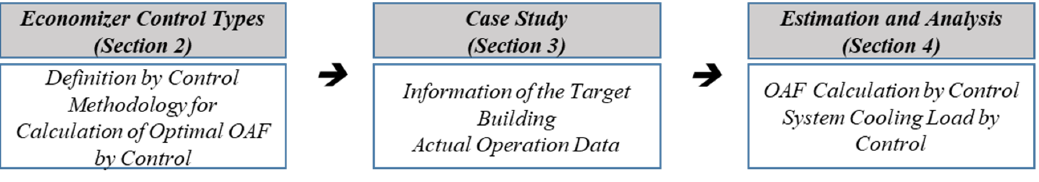
Figure 1. The procedure of the research.